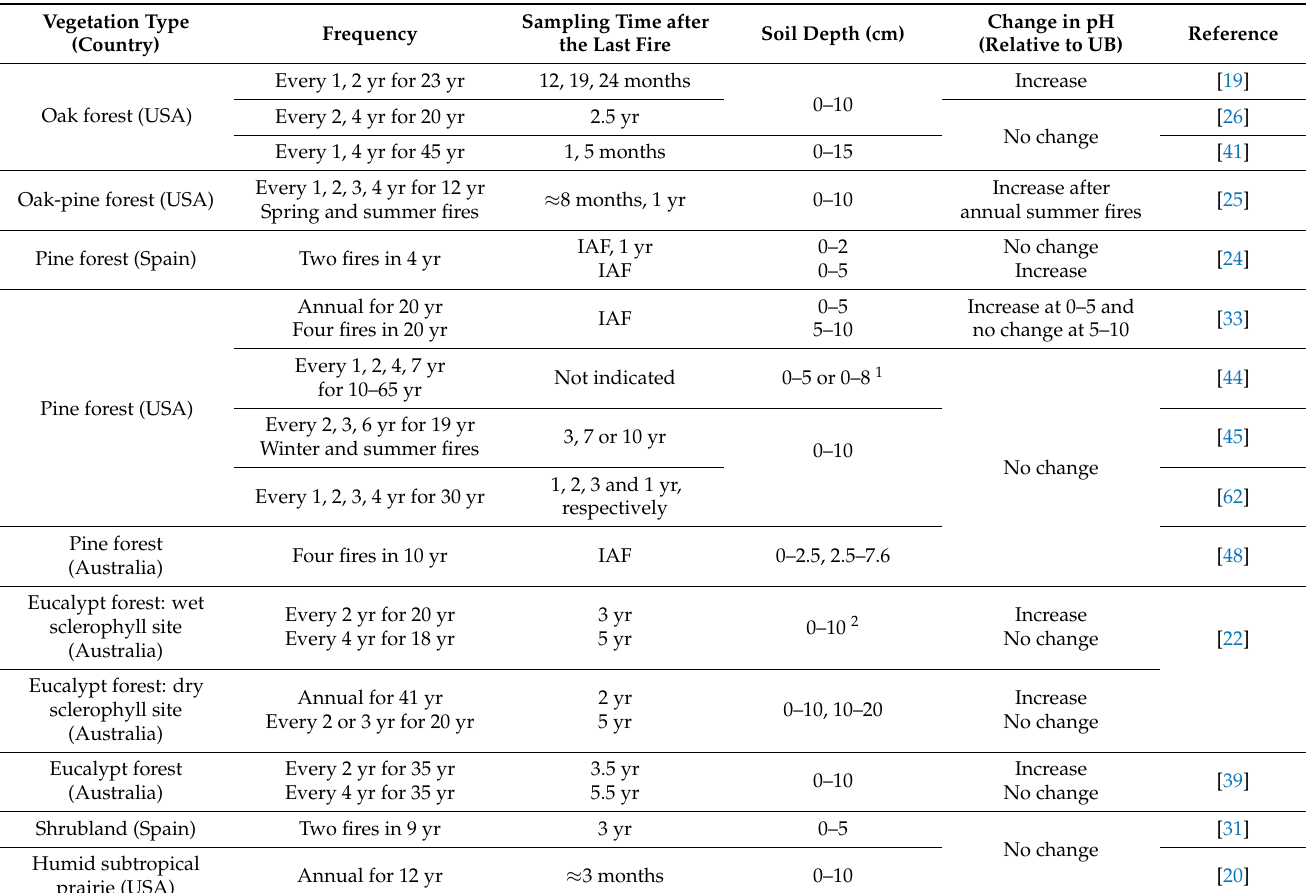
Table 6. Studies including the effects of repeated prescribed fires on soil pH. UB: unburned soil; yr: year; IAF: immediately after